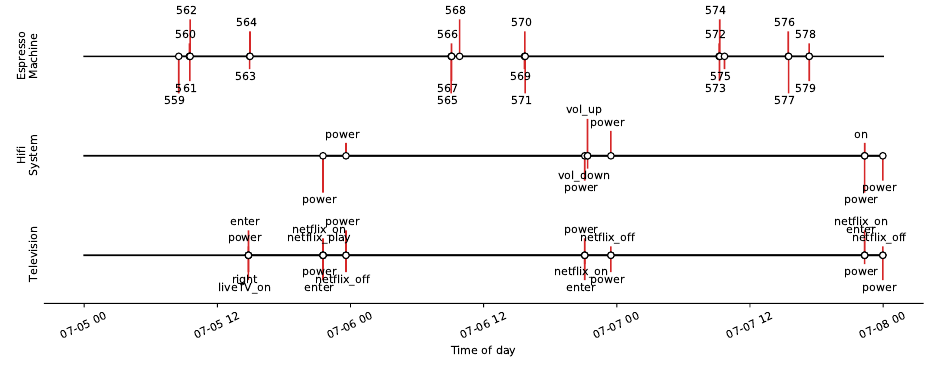
Figure 9. Two days of light usage information (16th–17th June 2020). The time of day is shown on the x -axis while the particular light is shown on the y -axis. If a light was used, a black box is shown during this period. The box is filled with the set color value and dimm setting.